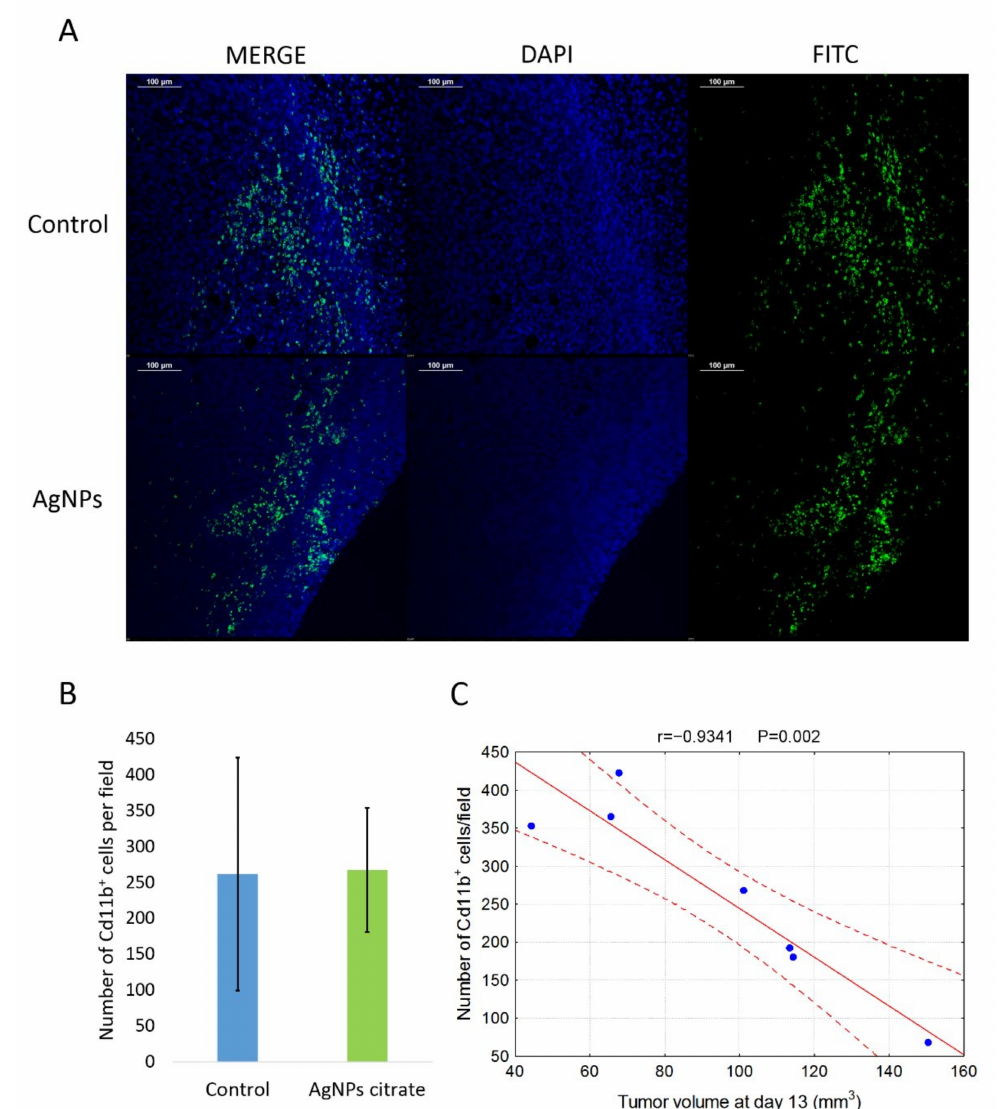
Figure 8. ( A ) Representative images of Cd11b + cells localization in tumor tissue from control and citrate-AgNPs-treated mice. Cell nuclei were stained with DAPI and Cd11b + cells were stained with FITC-conjugated antibody. ( B ) Mean number ± standard deviation of Cd11b + cells per field in tumor tissue from four control mice and three AgNPs-treated mice. ( C ) Correlation between the number of Cd11b + cells and tumor volume on day 13 of tumor